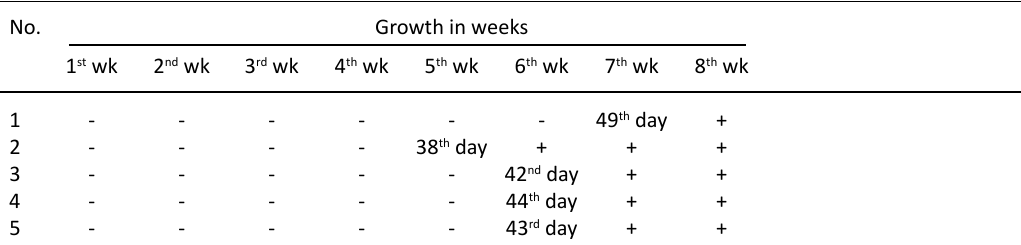
Table 5(b). Time to detection (TTD) of culture positivity samples in LJ medium No.